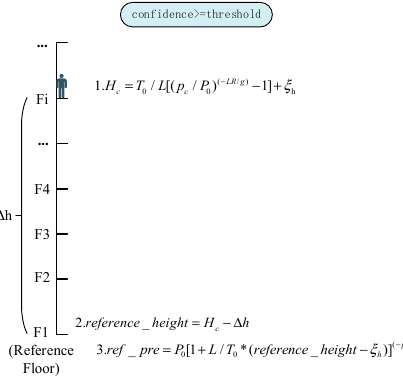
Figure 2. The reference pressure calibration.